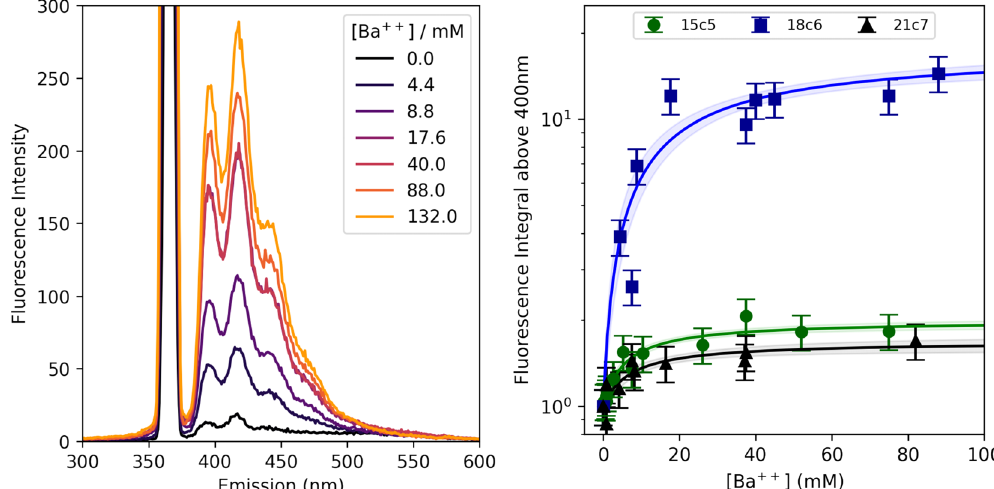
Figure 4. Left: Titration study showing increase in fluorescence intensity with added barium to 18c6-an. Right: Titration curves for anthracene derivatives with fits for Kd overlaid.